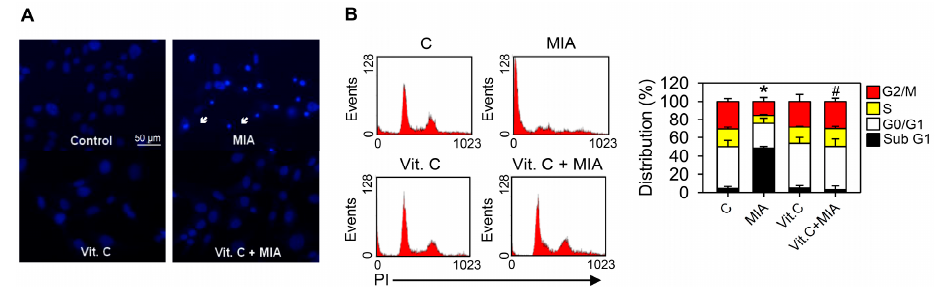
Figure 3. Effects of MIA and/or vitamin C on apoptosis induction and cell cycle progression. SW1353 cells were incubated with 100 µ M vitamin C in the presence or absence of 5 µ M MIA for 24 h, and then ( A ) apoptosis was determined by Hoechst 33342 staining; and ( B ) the distribution of cells in the different phases of the cell cycle was determined by flow cytometry. In ( A ), the white arrows indicate an apoptotic cell; in ( B ), the down panel indicates the percentage of cell cycle distribution. The results are expressed as the mean ± S.D. for three separate experiments, each in triplicate. * p < 0.05 compared to the untreated control. # p < 0.05 compared to the MIA treated group.